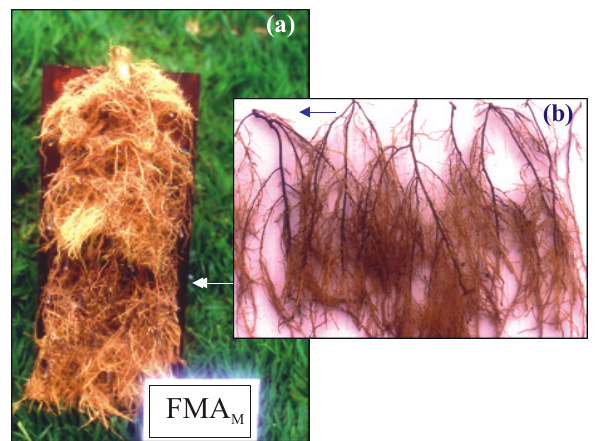
Figura 1. Crescimento do sistema radicular nas colunas de solo, destacando-se a população de raízes no terceiro anel (a) e rebrota das raízes após a realização da poda